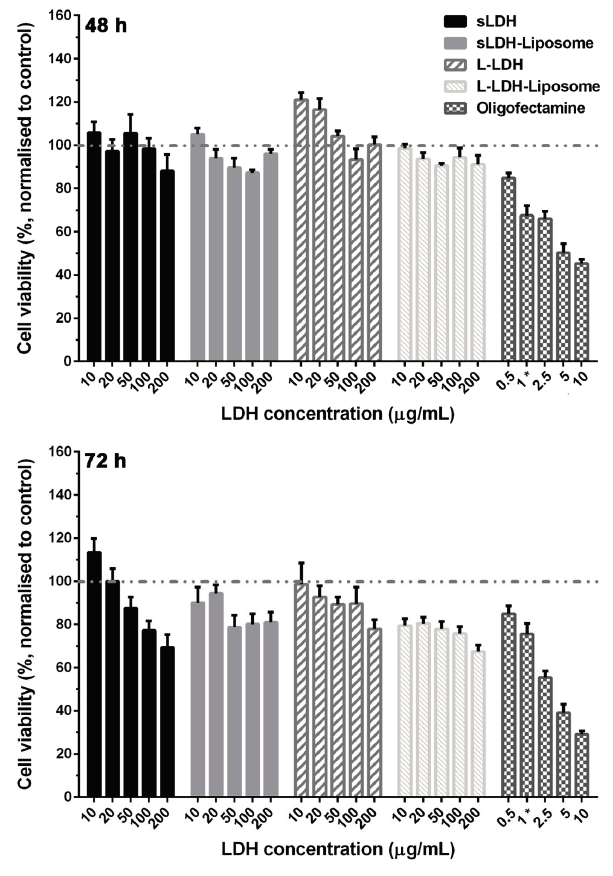
Figure 4. Cell viability of LDH and LDH–liposome NPs (MTT assay, in LDH–liposome formulations; LDH:EPC mass ratio = 1:1; transfection reagent Oligofectamine™ was used as the positive control; 1 * = minimum recommended dose of